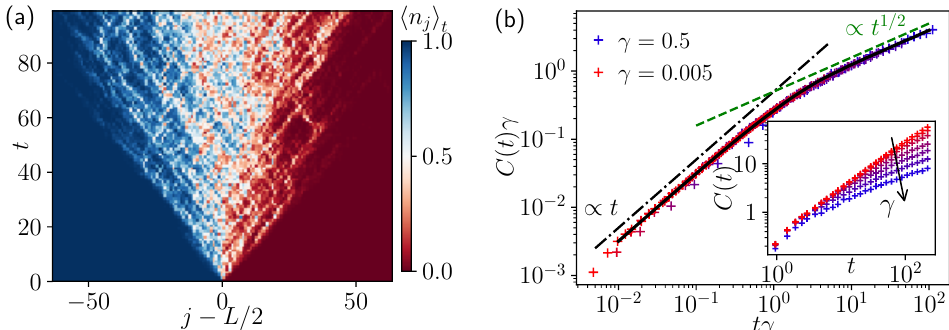
Figure 3: Non-equilibrium transport from a domain wall initial condition. (a) Evolution of local occupation numbers in a typical QT. (b) The averaged current (cid:10) (cid:11) (cid:80) C ( t ) = n in a system of L = 512. Main : Cross-over from ballistic transport j j > L / 2 t C ( t ) ∝ t (the coefficient is set by the γ = 0 limit) to a diffusive one C ( t ) ∝ t 1 / 2 γ − 1 / 2 . The solid curve is the hydrodynamic prediction (23), calculated by sampling 1000 independent random trajectories. Inset : Raw